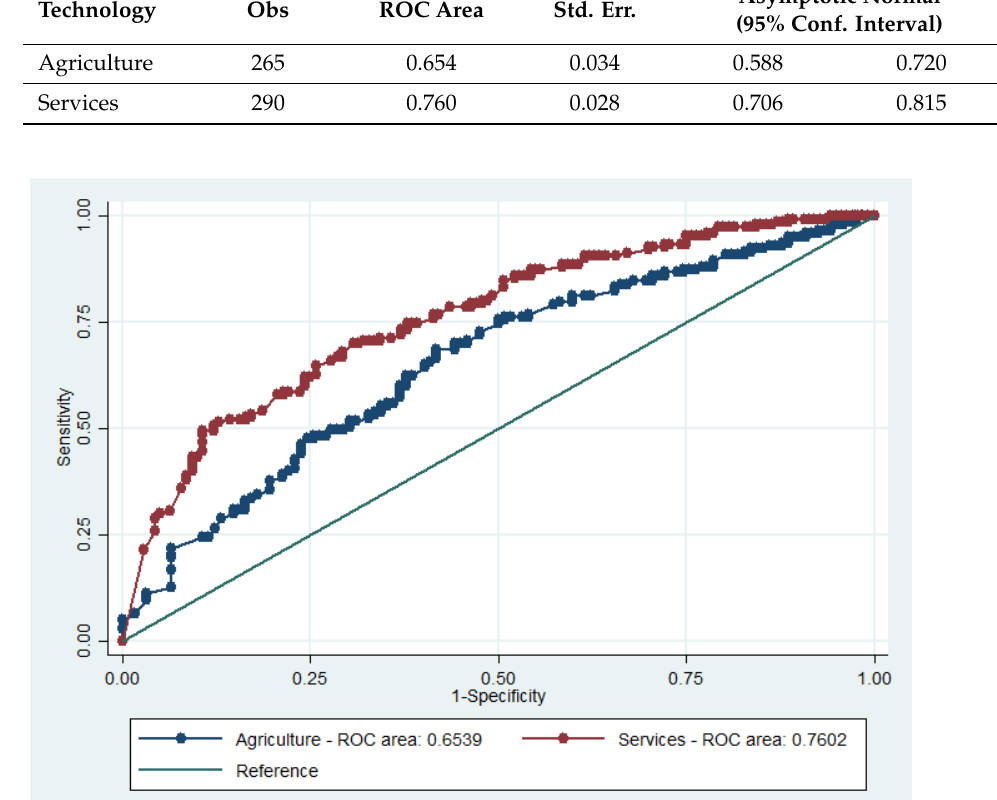
Table 17. Comparison of the ROC areas—sectoral subsample models (firms). Table 18. Wald test results for the pooled and sectoral subsample models (firms).